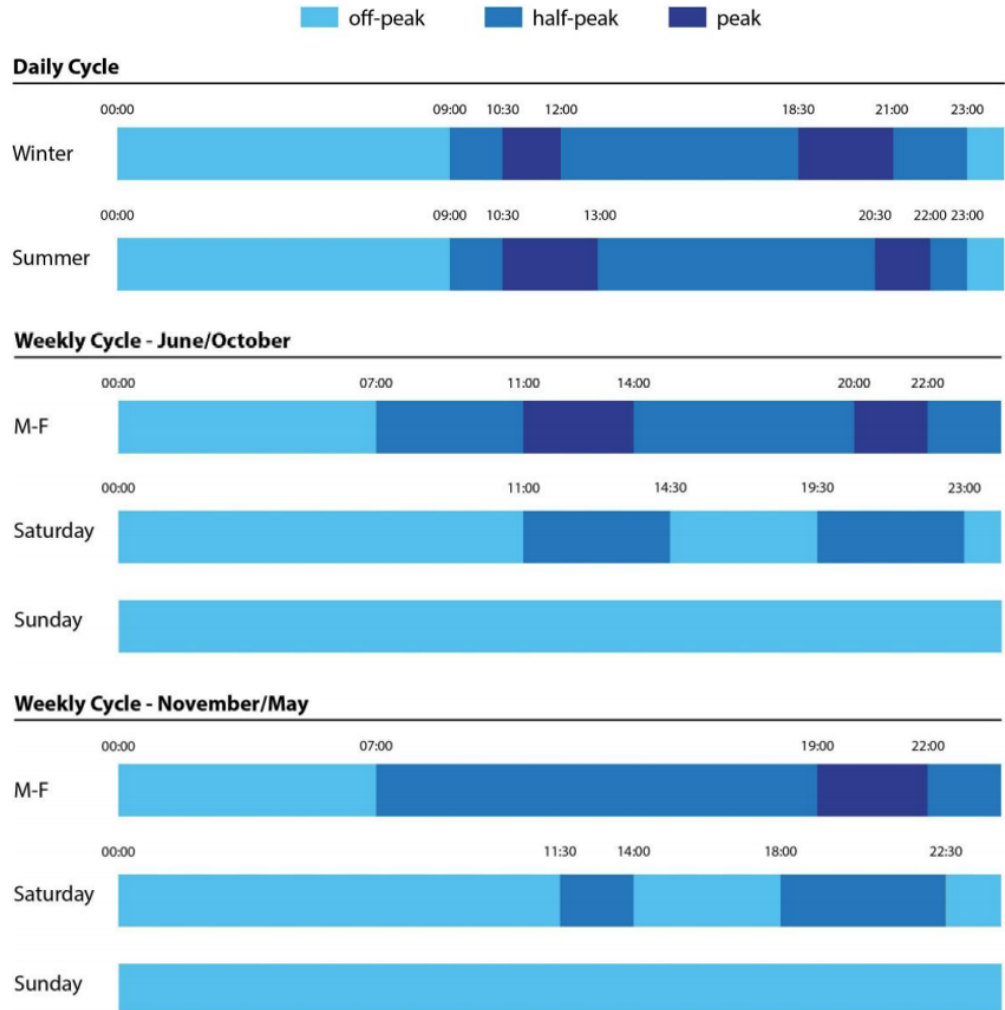
Figure 8. Energy price zones for the tri-hour tariff in Madeira. The information in the figure has been provided by the experts of the